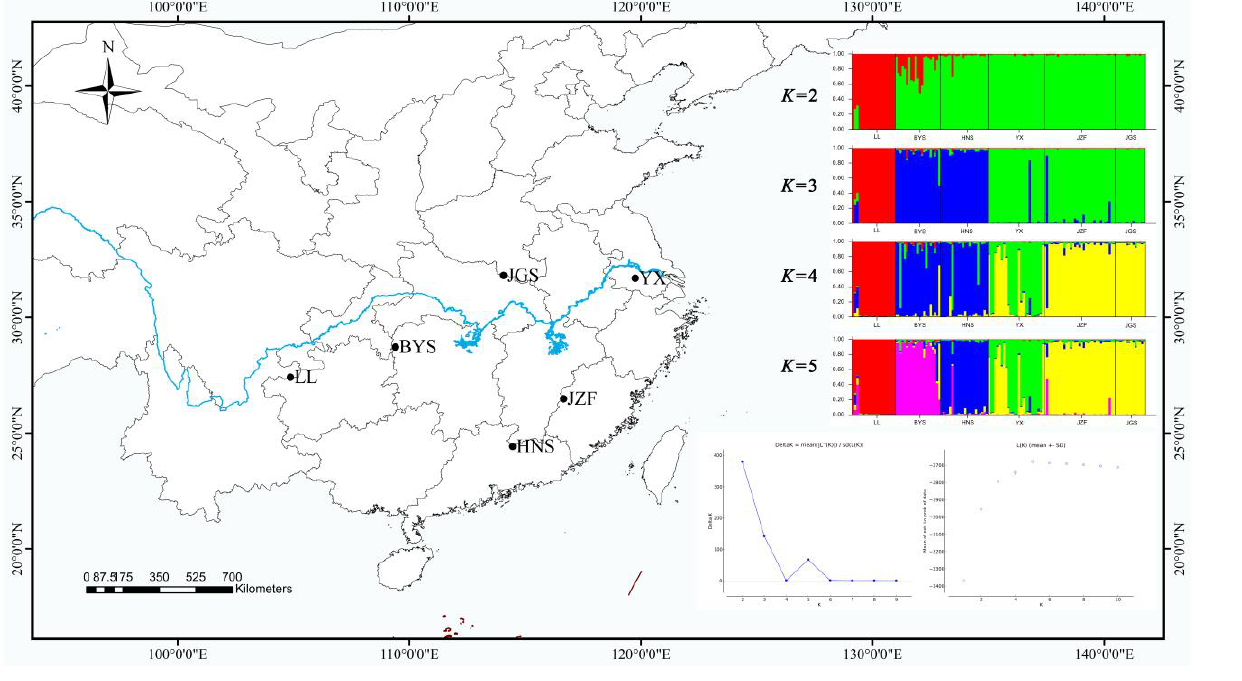
Figure 2. Geographic distribution of six populations of S. tzumu in China and population genetic structure among six populations of S. tzumu estimated using STRUCTURE based on nSSR with values of K from 2 to 5.